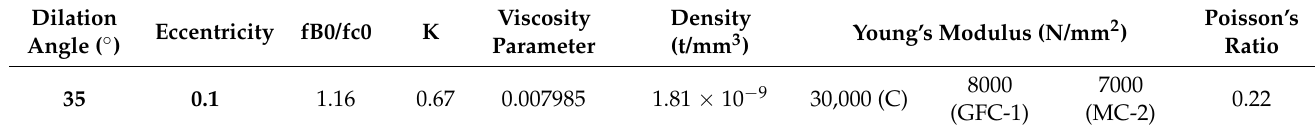
Table A5. Concrete damage plasticity, density, young’s modulus, and poisson’s